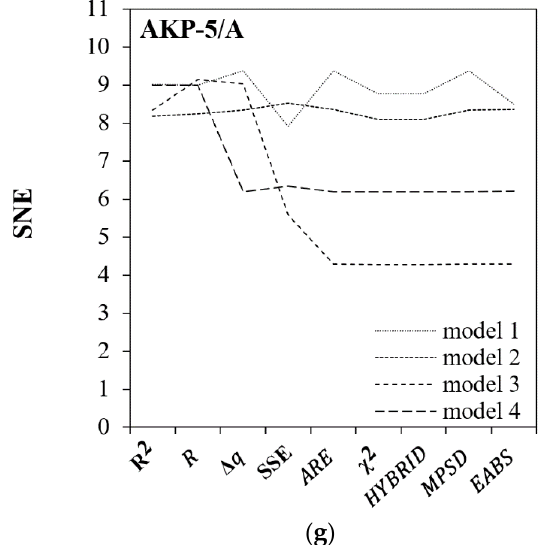
Figure 4. SNE error analysis for kinetic models solved by non-linear regression method for the following mixtures: ( a – e ) SO 2 + Ar, ( f , g ) SO 2 + O 2 + H 2 O (g) + Ar.